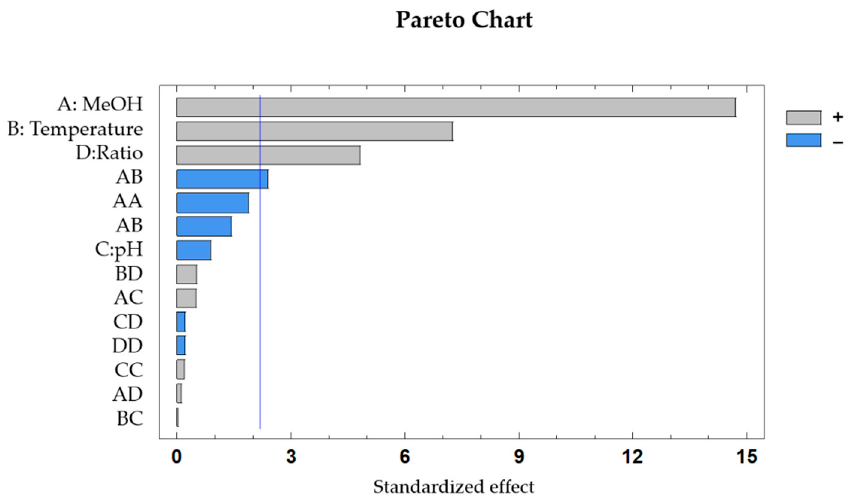
Figure 2. Standardized Pareto chart for the extraction of anthocyanins in Erica auntralis flowers ( p < 0.05). A: %MeOH in the solvent; B: Extraction temperature; C: pH of the extraction solvent; D: Sample to solvent ratio.